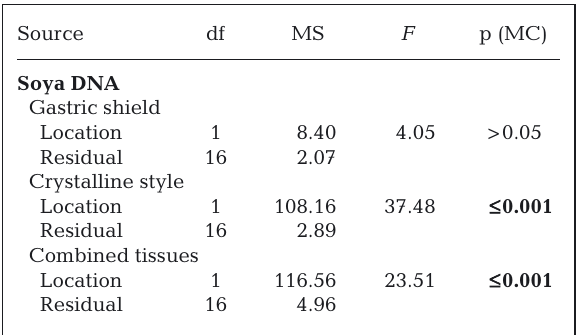
Table 4. PERMANOVA of differences between farm and ref- erence locations in the detection of soya Glycine max